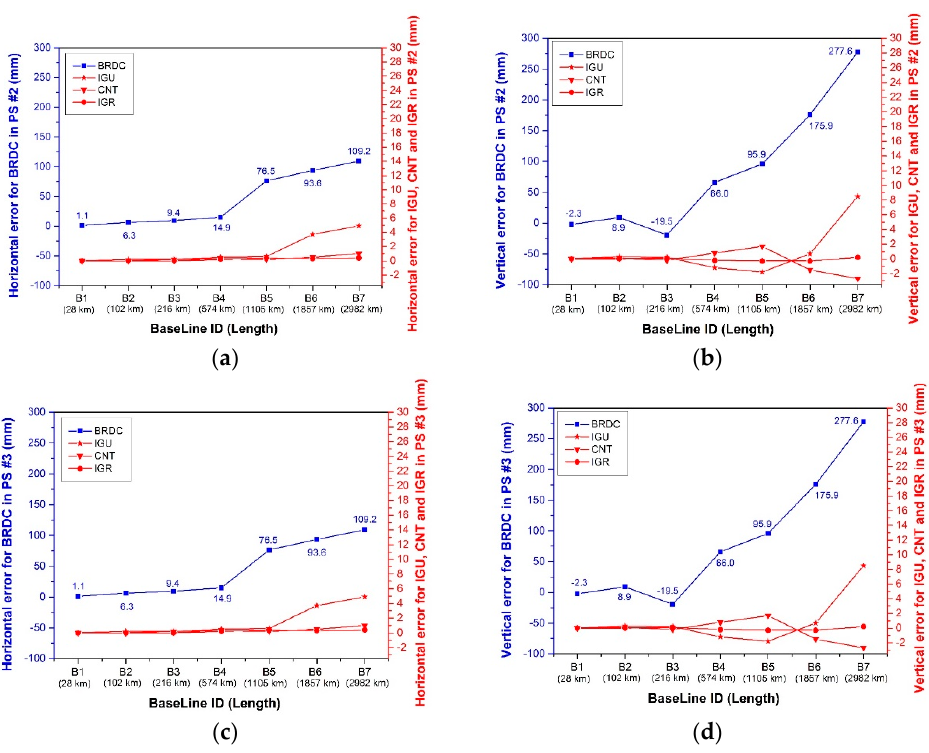
Figure 4. Horizontal ( a,c ) and vertical ( b,d ) relative positioning errors of the PS #2 ( a,b ) and #3 ( c,d ) on DOY 279.